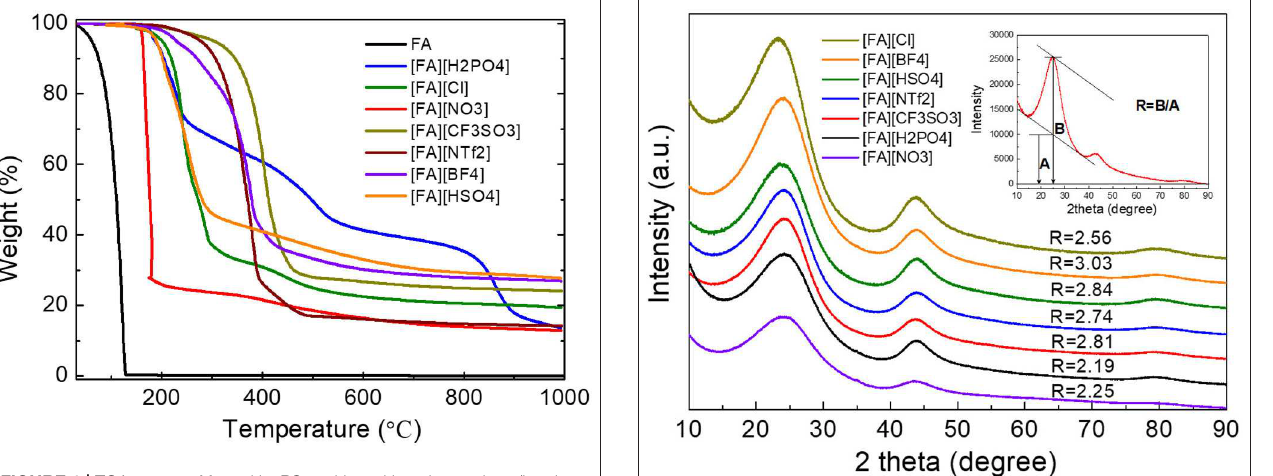
FIGURE 1 | TGA curves of fa and its PSs pairing with various anions (heating rate: 10 ◦ C/min under argon flow 200 mL/min). Note that [FA][NO 3 ] was heated at a heating rate of 1 ◦ C min − 1 .